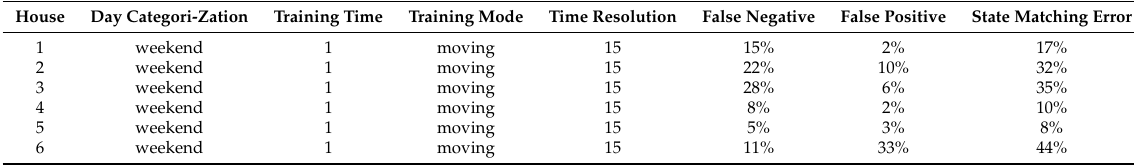
Table 5. Results of universal occupancy prediction model for each